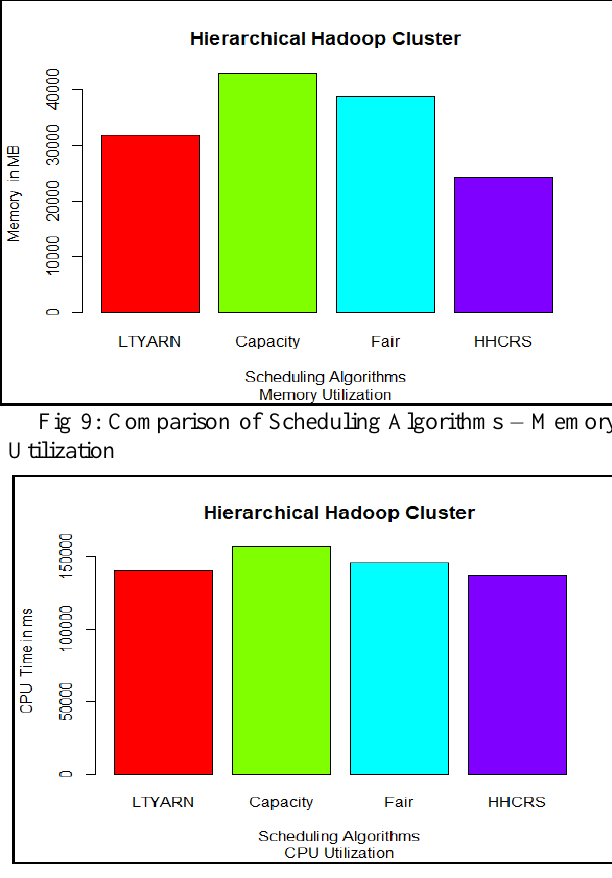
Fig 8: Comparison of Scheduling Algorithms – CPU Utilization